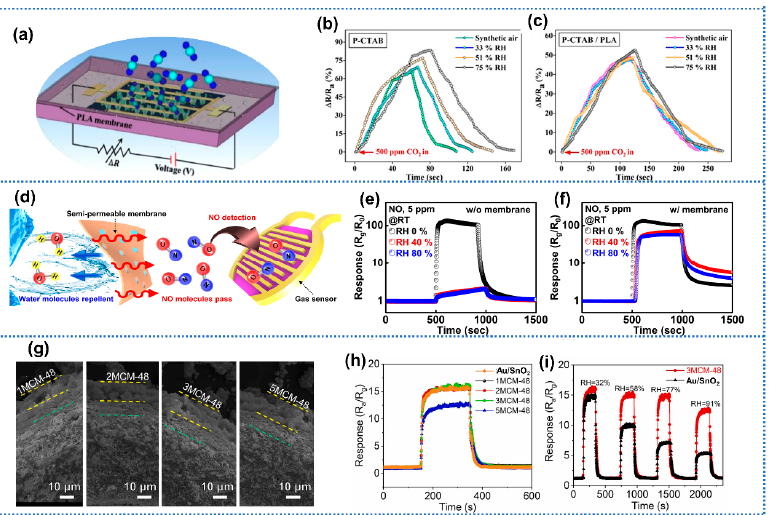
Figure 8. ( a ) Schematic diagram of sensor with PLA membrane coating. Effect of humidity on ( b ) P-CTAB and ( c ) P-CTAB/PLA sensors toward CO 2 . Reprinted with permission from Ref. [112]. Copy- right 2020, American Chemical Society. ( d ) Schematic illustration of the principle of enabling gas measurements in humid conditions. Semipermeable membranes (polydimethylsiloxane, PDMS, thickness ~50 μ m) selectively allow for the passage of gas molecules while acting as a barrier to water molecules. The dynamic responses of integrated gas sensors ( e ) without and ( f ) with a semi- permeable membrane to 5 ppm NO 2 at several levels of relative humidity. Reprinted with permis- sion from Ref. [44]. Copyright 2020, Springer. ( g ) SEM image of a formaldehyde sensor device with different thickness of MCM-48 layer. ( h ) Response values of the pure Au/SnO 2 , 1MCM-48-Au/SnO 2 , 2MCM-48-Au/SnO 2 , 3MCM-48-Au/SnO 2 , and 5MCM-48-Au/SnO 2 at 25% RH, respectively. ( i ) Dy- namic curve of 3MCM-48-Au/SnO 2 and Au/SnO 2 sensors at different RH environments. Reprinted with permission from Ref. [116]. Copyright 2022, Elsevier. 3.3. Working Parameter Modulation Operating temperature is one important parameter to affect the operation perfor- mance of gas sensors in terms of sensitivity, response/recovery time, and selectivity. Ad- ditionally, the water adsorption on the sensing film is related to the operating tempera- ture. Wu et al. [46] performed the regulation of operating temperature on NO 2 sensor based on SnO 2 -graphene hydrogel to improve its humidity tolerance (Figure 9a). When the operating temperature was increased from 20 to 54 °C, the response drifts toward 3 ppm NO 2 caused by RH changing from 5% to 80% RH reduced from 30.8% to 9.9% (Figure 9b). The elevated operating temperature could facilitate the desorption of water and thus reduce the humidity interference on gas detection. Moreover, the authors improved the humidity immunity of Au-modified graphene hydrogel based NO 2 sensor by increasing the operating temperature [120]. However, the response to NO 2 appeared to decline with the elevating operating temperature in their works. In regard to CGS, sensitivity is closely related to the operating temperature. This phenomenon suggested that if the operating temperature does not match the optimal one, elevating the operating temperature for hu- midity tolerance probably led to sensitivity reduction. Moreover, adjuvant UV light illu- mination was another feasible method to improve humidity tolerance. Chen et al. [47] introduced UV-light illumination on one NO 2 gas sensor based on WS 2 /PbS. After intro- ducing UV light, the sensor exhibited less water-susceptible response to 1 ppm NO 2 over a humidity range of 10–90% RH (Figure 9c,d). Generally, the adsorbed water on the